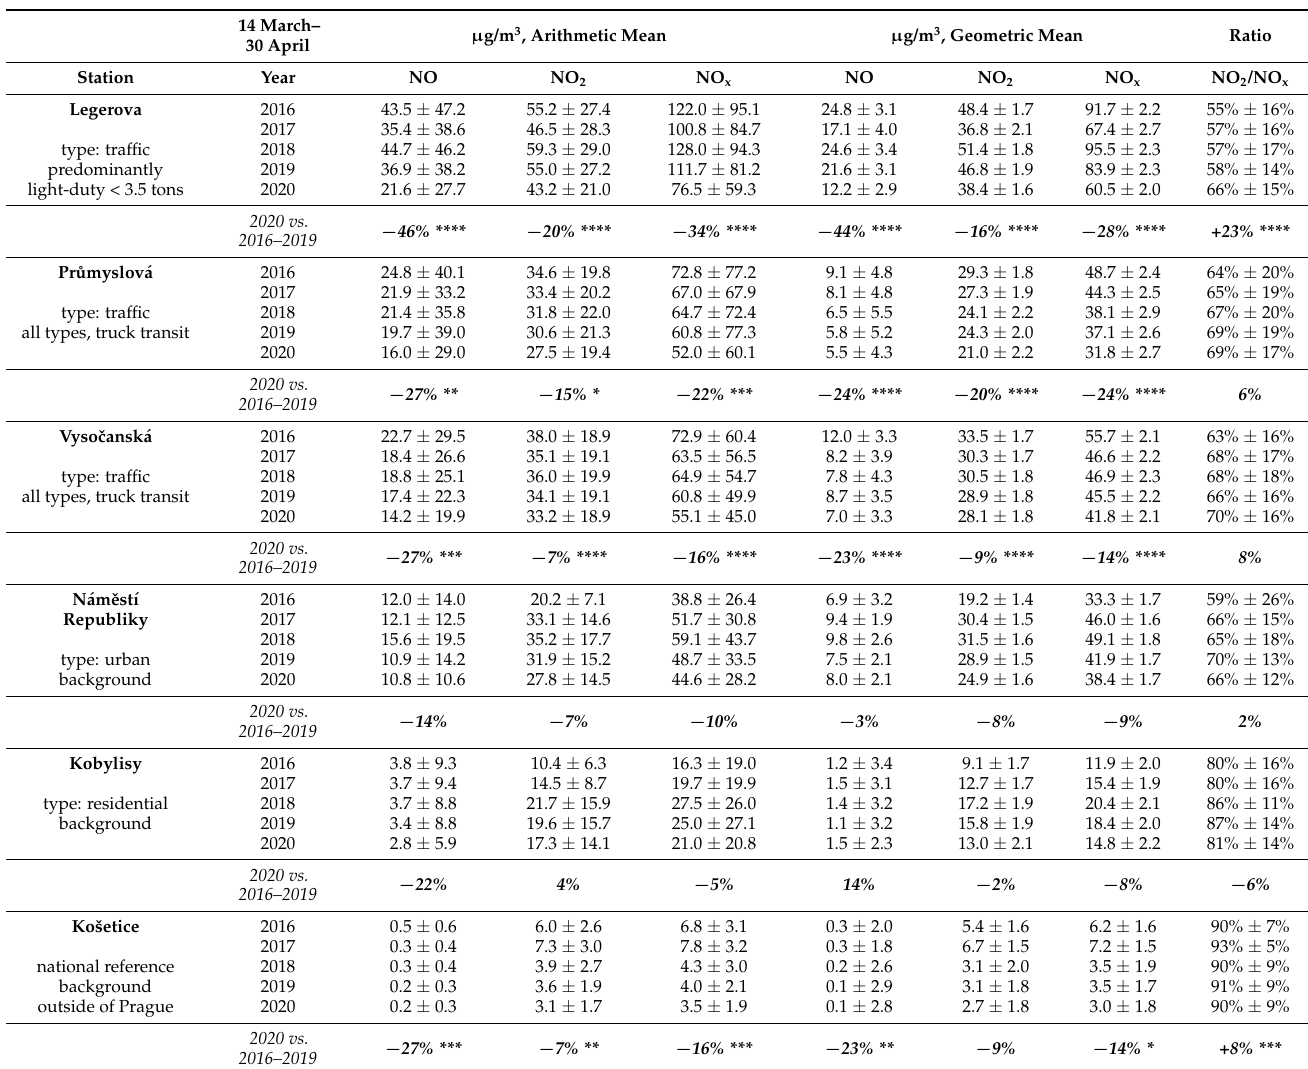
Table 3. Comparison of NO and NO 2 concentrations at six monitoring stations during March–April 2020 travel restrictions with the same period during the prior four